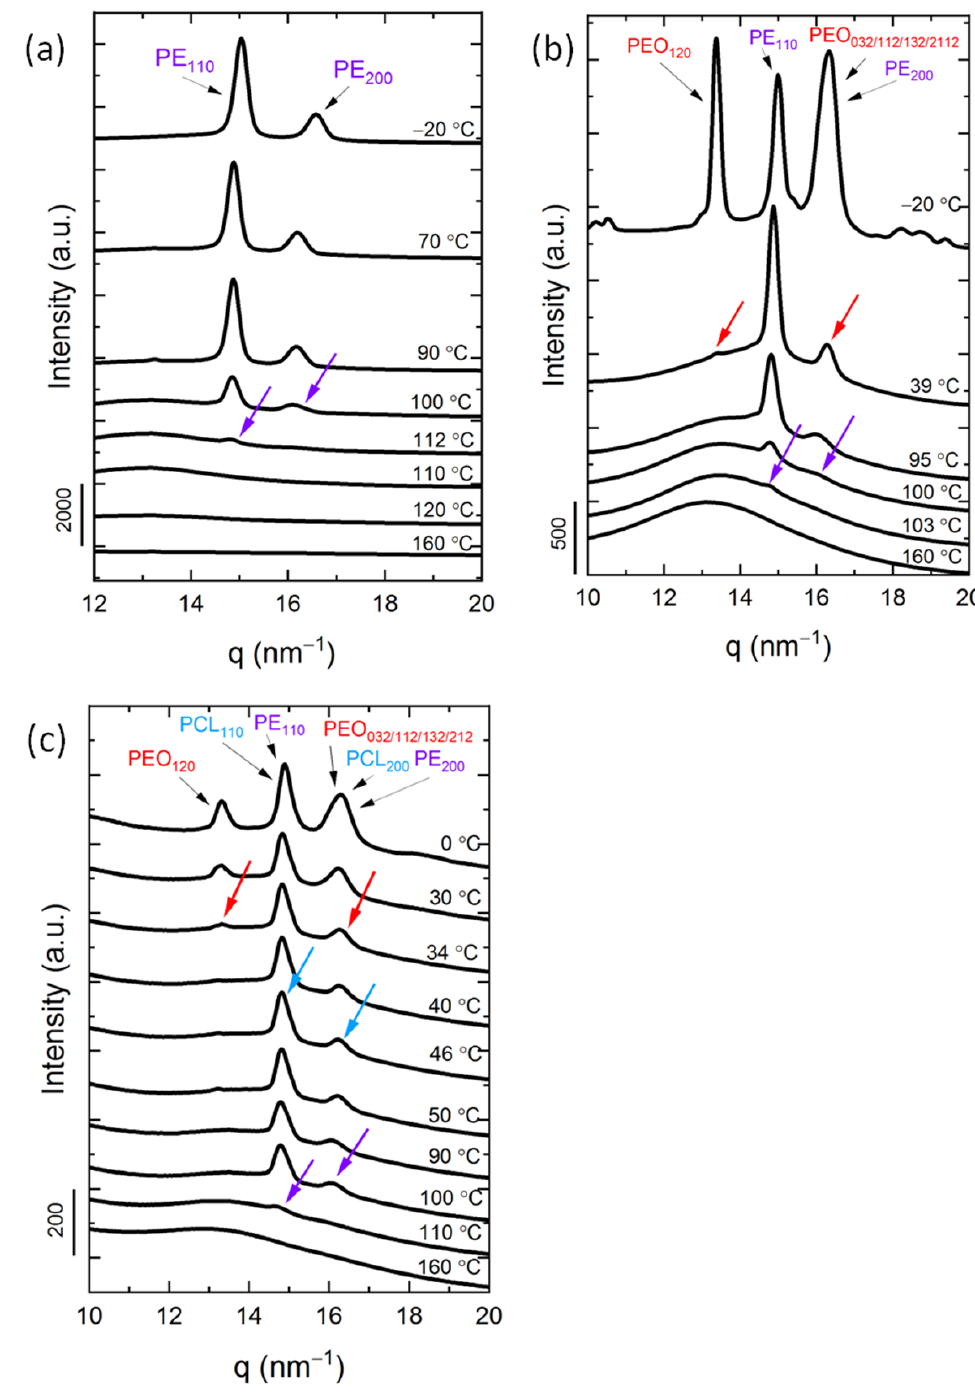
Figure 7. WAXS patterns upon cooling from the melt at 20 ◦ C/min for ( a ) PE 9.5 , ( b ) PE 52 9.5 - b -PEO 48 8.8 , and ( c ) PE 37 9.5 - b -PEO 34 8.8 - b -PCL 29 7.6 (T2) at different temperatures with colored arrows indicating crystallization of each block and (hkl)